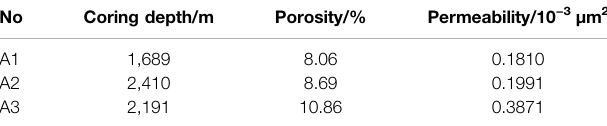
TABLE 1 | Petrophysical properties of core chips used in imbibition test.